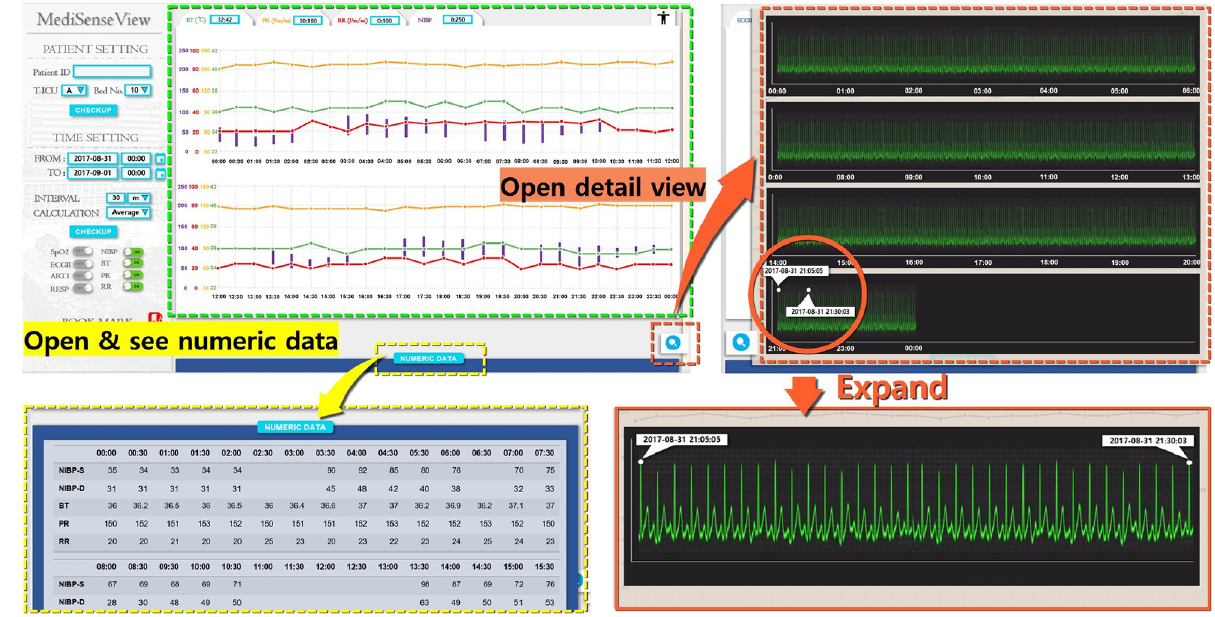
Fig 10. The third revision of MediSenseView . This version is designed based on the feedback from the second design meeting with the trauma center panel. We present how the screen expands as different buttons are pressed.